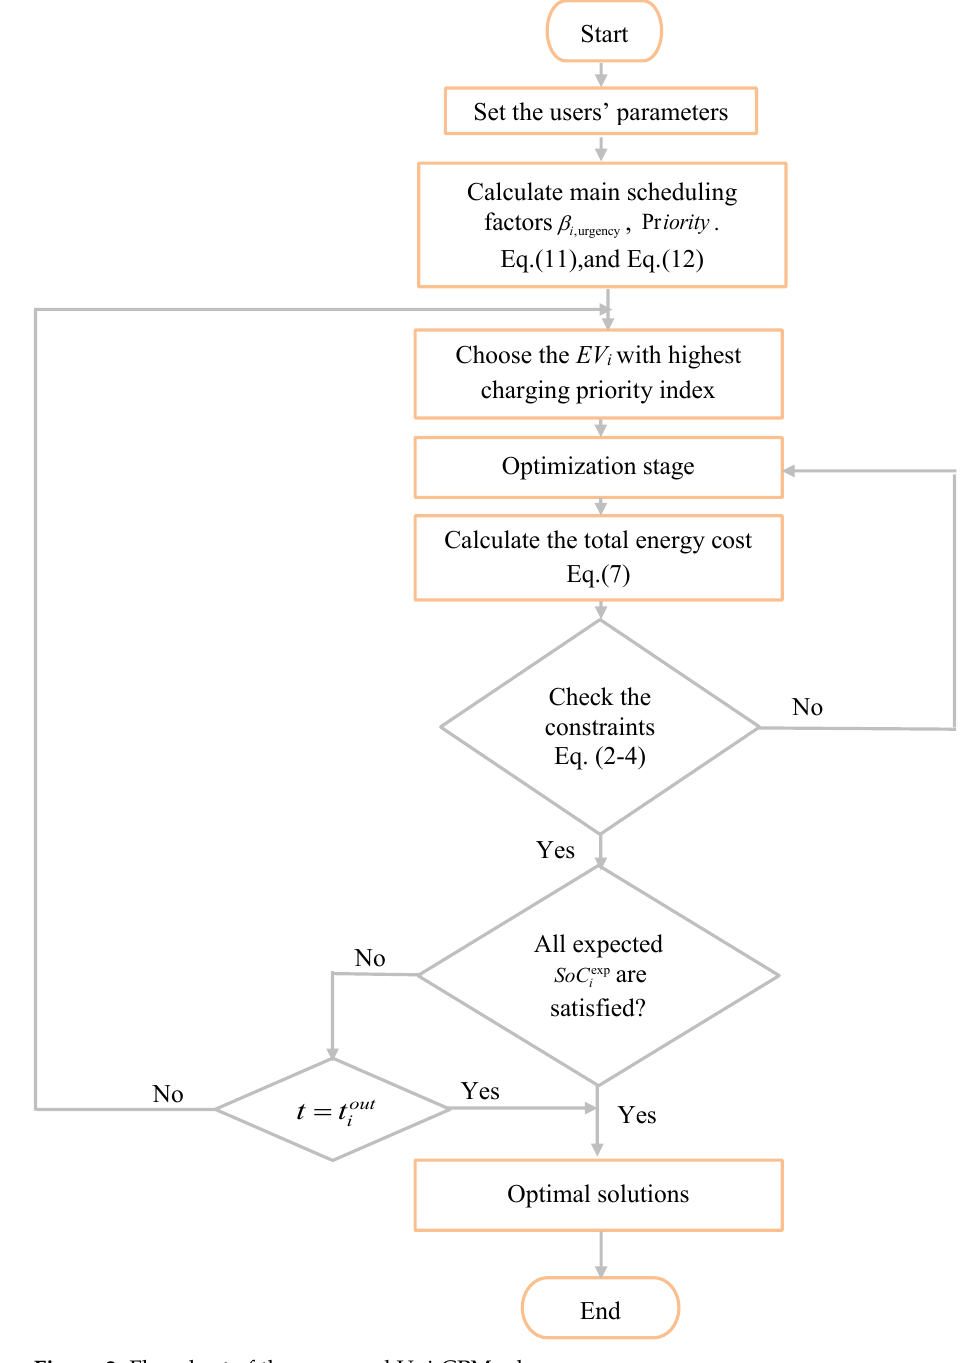
Figure 2. Flowchart of the proposed Uni-CPM